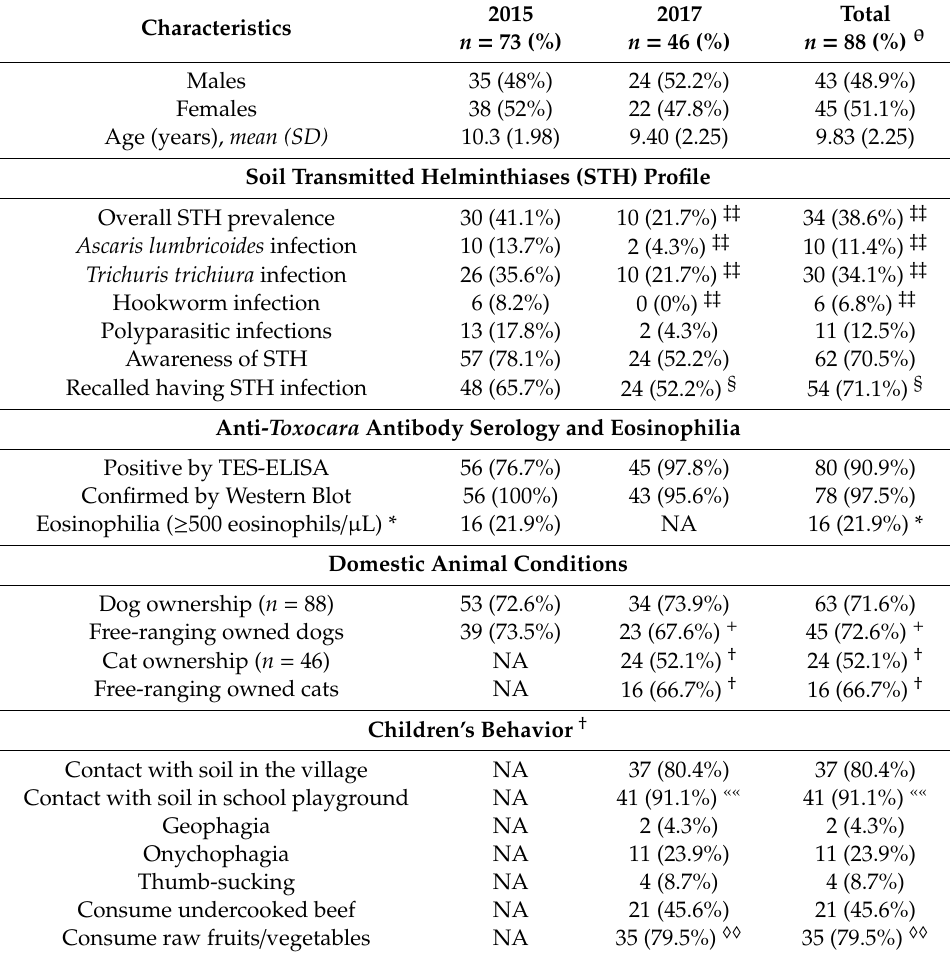
Table 1. Study sample characteristics and laboratory results by year of study. Since there were 31 children who participated in both years, the final sample size amounts to a total of n =